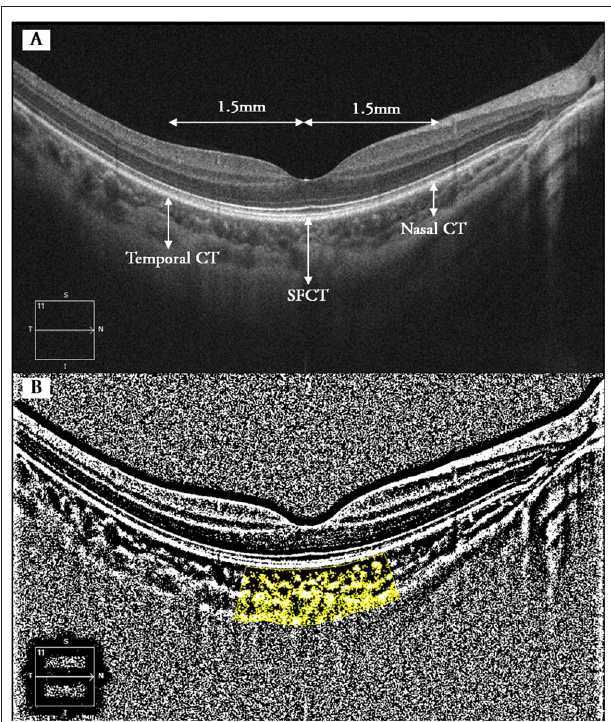
FIGURE 1 | Binarization analysis of choroidal structure from OCT images. (A) Five locations where CT and CVI were measured (superior and inferior not shown). (B) Identification of the subfoveal choroidal segments using the binarization technique. Dark pixels refer to vascular components of choroid, whereas white pixels represent stromal components. CT, choroidal thickness; SFCT, subfoveal choroidal thickness; CVI, choroidal vascularity index.